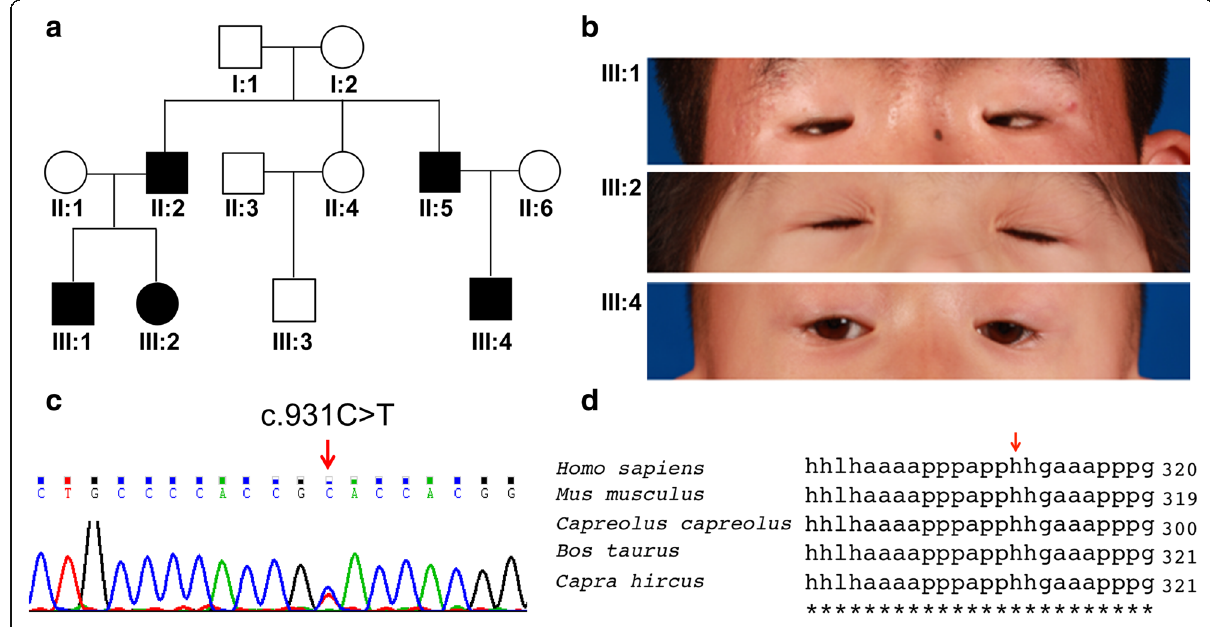
Fig. 1 Detection of FOXL2 mutation in BPES patients. a . The Pedigree of a Chinese family with BPES. b . Representative images of BPES patients. c . Sequencing result indicating the c.931C>T mutation in the FOXL2 gene. d . Alignment of FOXL2 proteins from different species showing the conserved site of